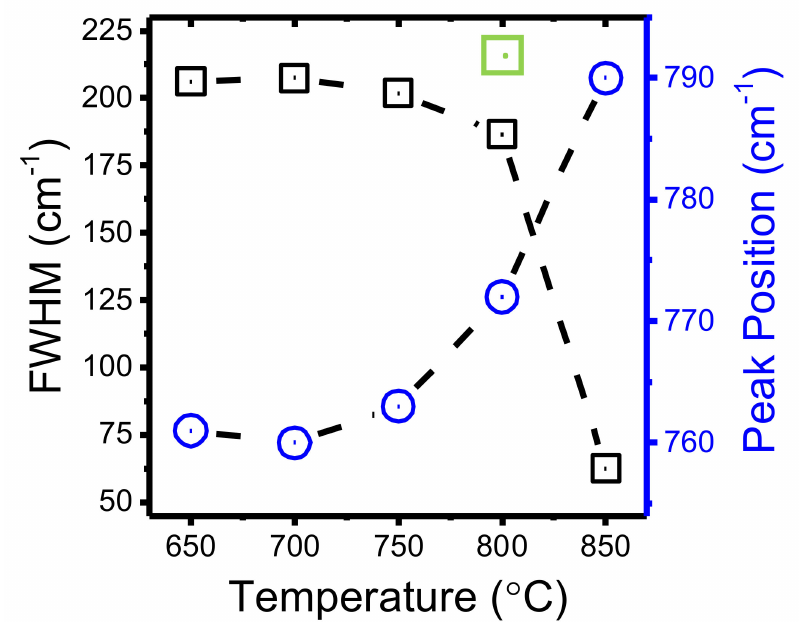
Figure 5. FTIR FWHM and peak position of the main stretching transverse optical (TO) Si–C absorption band as a function of deposition temperature for as-deposited TSCH-derived SiC films. The FWHM for SiC films grown using TMDSB as the source precursor at a substrate temperature of 800 ◦ C is included for comparison (data point in